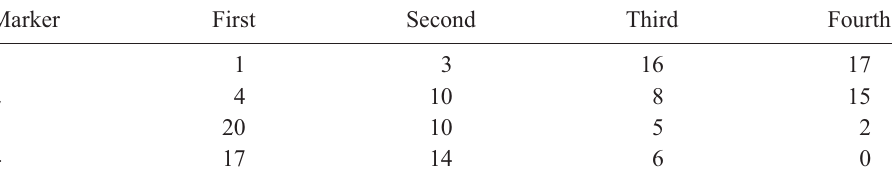
Table 3. Marker trends when four marks for each student are placed in rank order.